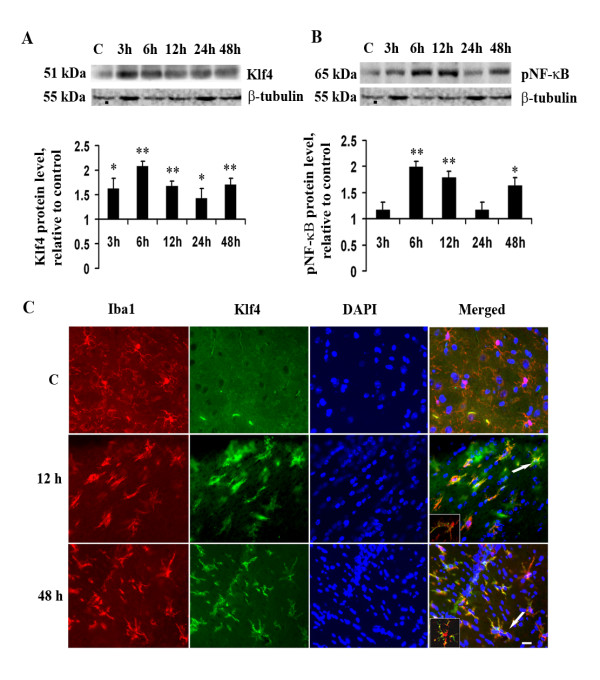
Klf4 expression in vivo upon LPS administration. Immunoblot and immunohistochemistry analysis of Klf4 expression in BALB/c mice brains upon LPS administration. (A) There are significant increases in Klf4 expression at different time points compared to control brain. (B) There is a significant increase in pNF-κB levels upon LPS administration in a time-dependent manner compared to control brain. The graphs represent pNF-κB and Klf4 protein levels in brains of LPS-treated mice relative to control mouse brain. *, **, Statistical differences in comparison to control values (* p < 0.05; ** p < 0.01). (C) Fluorescent microscopy images of Klf4 expression in microglial cells in brain cortices of control and LPS-treated mice. Klf4 (FITC, green) co-localizes with Iba1- (Alexa Fluor 594, red) positive microglial cells at 12 h and 48 h after LPS administration. Co-localization is shown by arrows in the merged images. Inset. The inset depicts high resolution confocal images of Klf4 and Iba1 co-localization (yellow) in single cells at the 12 h and 48 h time point. Data represent groups of 3 animals per treatment. Scale bar: 50 μm.